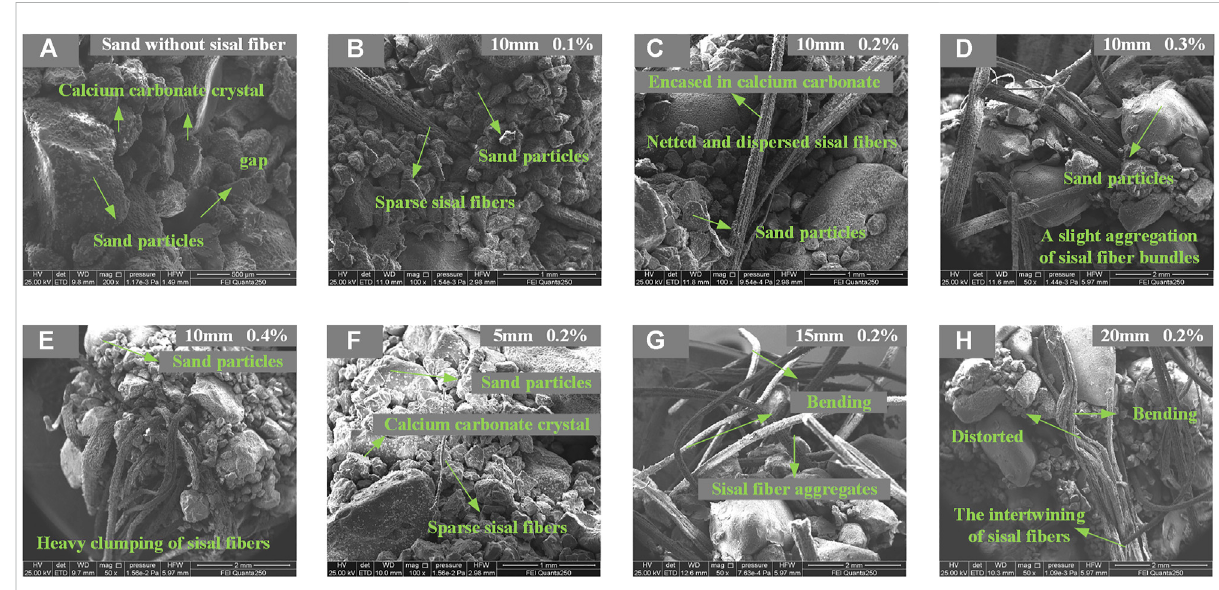
FIGURE 9 SEMimagesofEICP-treatedsandreinforcedwithsisal fi bersatdifferent fi bercontents: (A) 0%; (B) 0.1%; (C) 0.2%; (D) 0.3%; (E) 0.4%.SEMimages of EICP-treated sand reinforced with sisal fi bers at different fi ber lengths: (F) 5 mm; (G) 15 mm; (H) 20 mm.